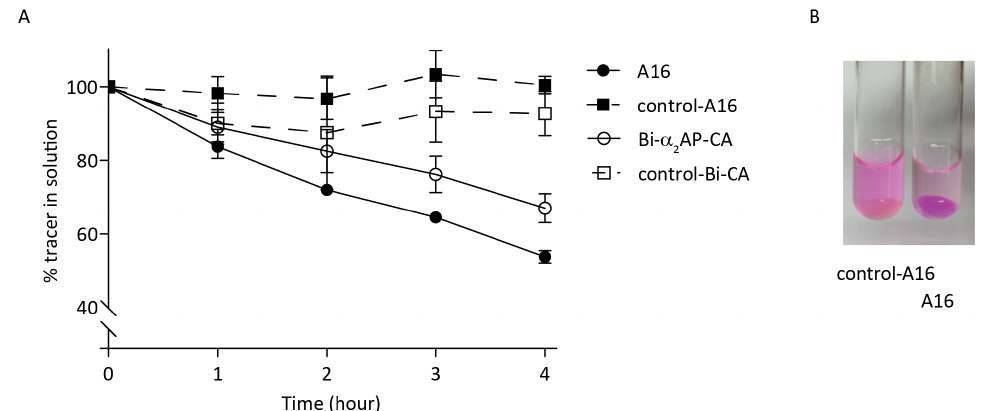
Figure 2. In vitro probe depletion. Human plasma was allowed to form thrombi in vitro at 37 °C for 90 min. ( A ) Rhodamine-labelled probes (3 µ M) were added to human thrombi. Solid lines = peptides (Q3), dashed lines = control peptides (Q3 → A3), parent peptide ( (cid:3) , OD (570 nm) in solution was measured after 1, 2, 3 and 4 h as a measure of probe incorporation in thrombi. Dots represent mean ± SD, n = 4. ( B ) Representative uptake of LisB-A16 vs control-LisB-A16 in thrombi.